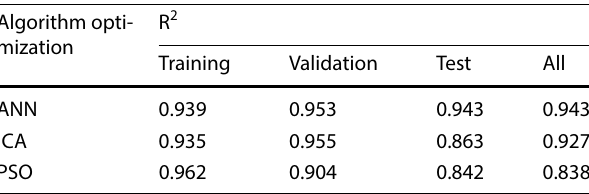
Table 7 The result of algorithm performance for different number of layers Algorithm opti-